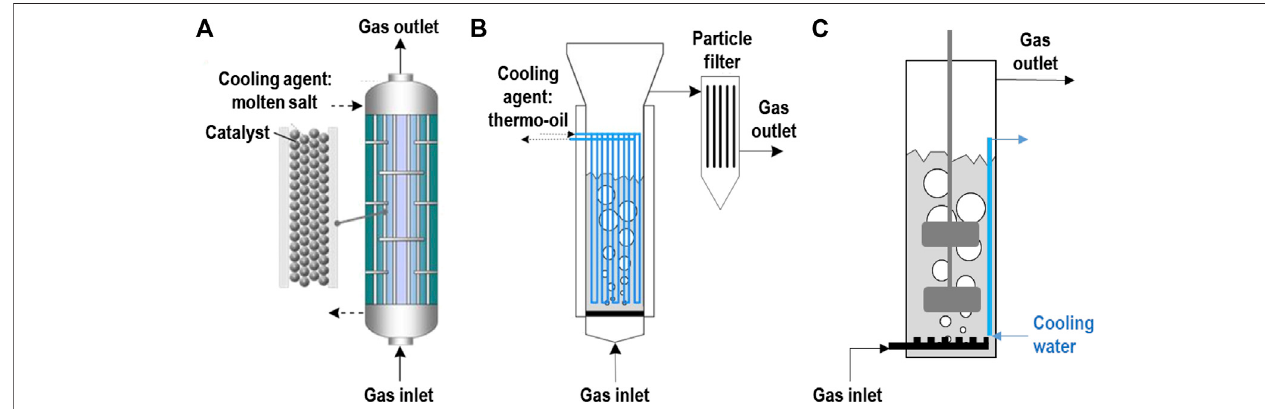
FIGURE 3 | Important methanation reactor concepts: (A) Cooled fi xed bed (left) , (B) Catalytic bubbling fl uidized bed (middle) , (C) Stirred bubble column for biological methanation (right) .